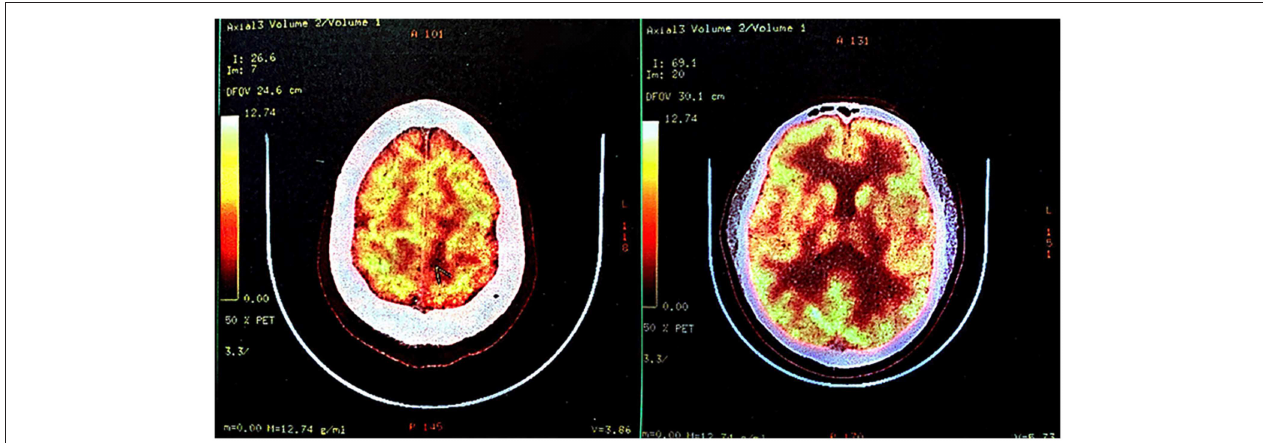
FIGURE 3 | Fluorodeoxyglucose-positron emission tomography-computed tomography (FDG-PET-CT) in October 2017. FDG-PET-CT indicated low glucose metabolism of left frontal-parietal lobe, which was suggestive of an intracranial primary benign lesion. appearance ( Figure 6C ). The intraoperative report indicated high-grade